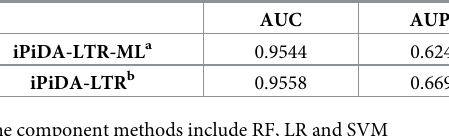
Table 3. The comparison results of predictors based on Learning to Rank integrating different component methods via five-fold cross-validation on and S p dataset.